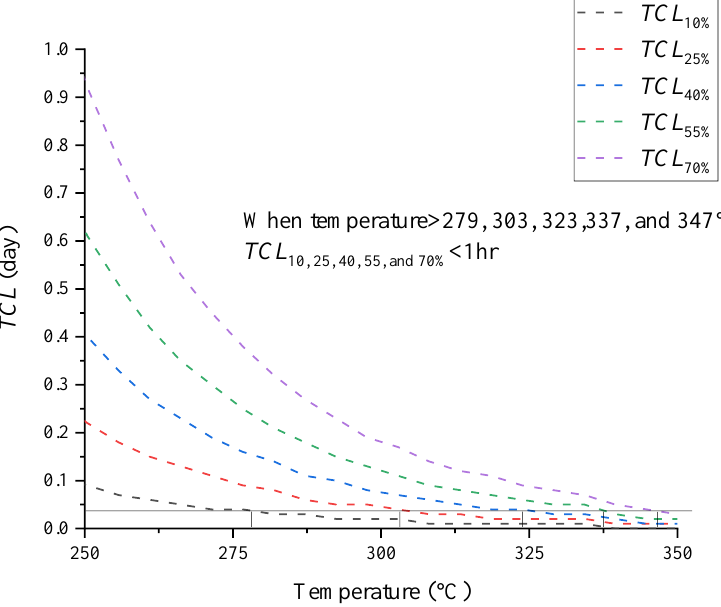
Figure 5. Simulation results of [BZMIM][TF2N] for TCL with the heating rate of 4.0 °C min − 1 .